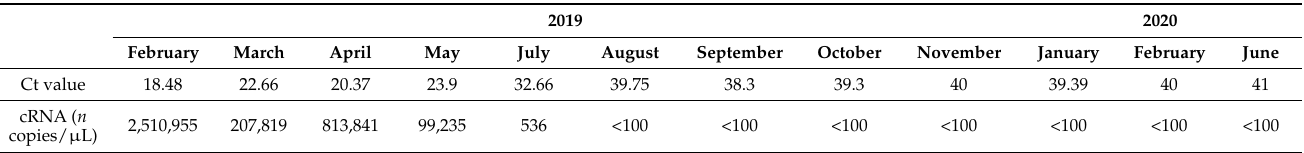
Table 1. Detection of canine distemper virus (CDV) RNA by real-time RT-PCR with corresponding viral genomic copy num- bers.